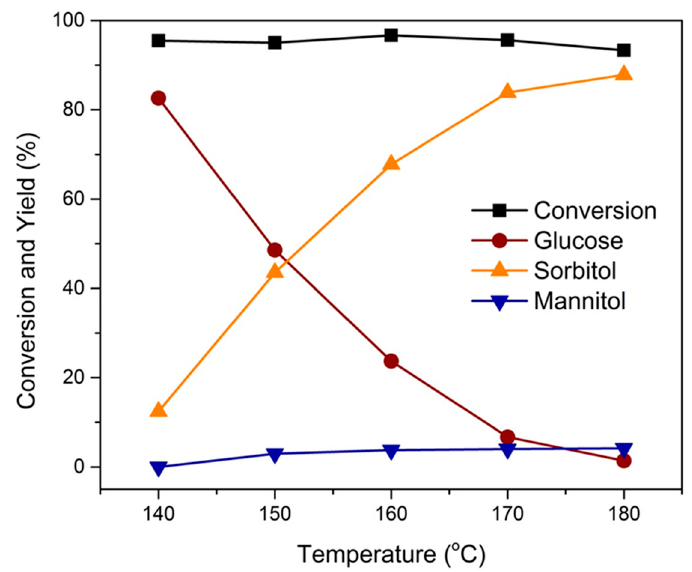
Figure 9. Effect of reaction temperature (140–180 ◦ C) on cellobiose conversion and product distribution in the hydrolytic hydrogenation of cellobiose for 3 h using 4 MPa of H 2 , 10 mL of 1% cellobiose solution, and 0.08 g of catalyst.